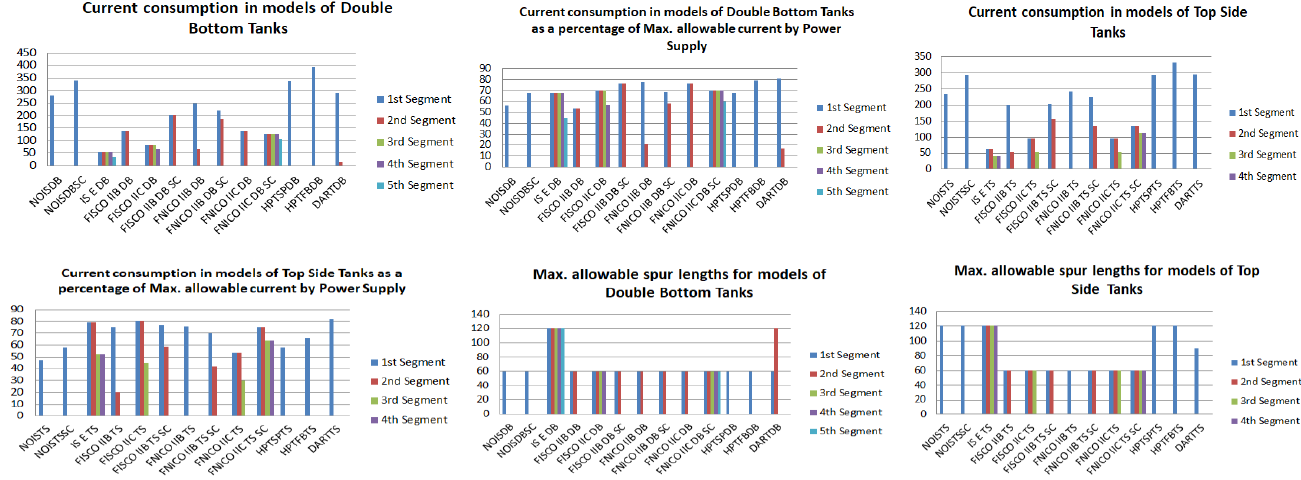
Figure 8. Total current consumption and maximum allowable spur lengths of all sub-models.